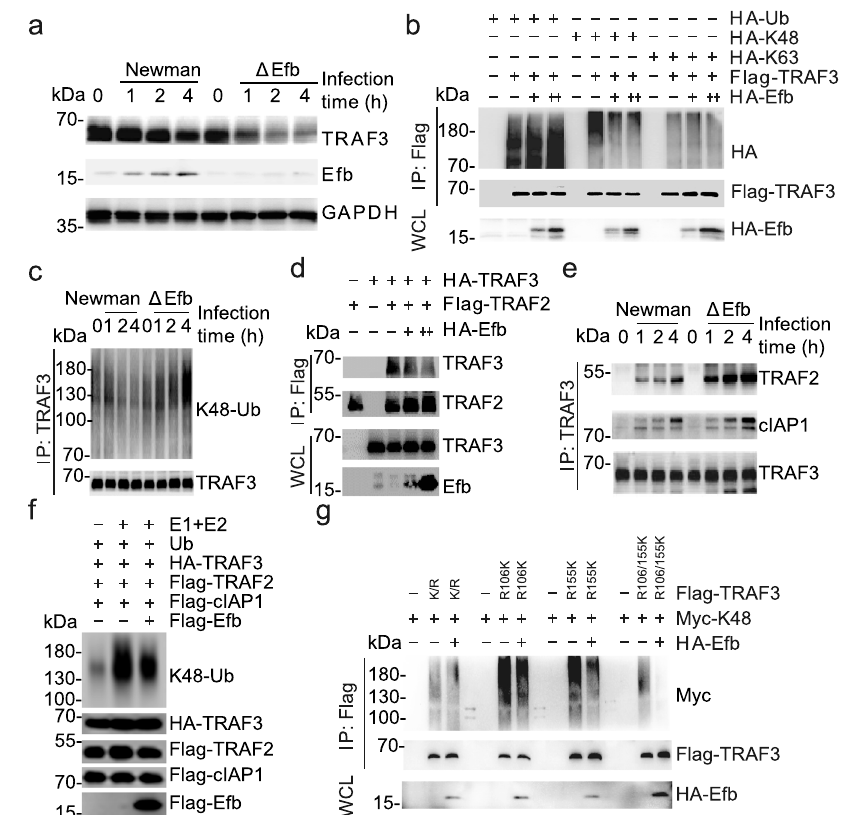
Fig. 4 | Efb stabilizes TRAF3. a Immunoblots of WCL from MH-S infected with Newmanand Δ Efb(MOI=25). b ImmunoblotsofWCLandIPproductsofWCLfrom HEK293T cells transfected with indicated plasmids. Ub, wild-type ubiquitin; K48, Ub with a single 48 lysine residue left; K63 Ub with a single 63 lysine residue left. c Immunoblots of IP products of WCL from MH-S infected with Newman and Δ Efb (MOI=25). d ImmunoblotsofWCLandIPproductsfromHEK293Tcellstransfected with indicated plasmids. e Immunoblots of IP products from MH-S infected